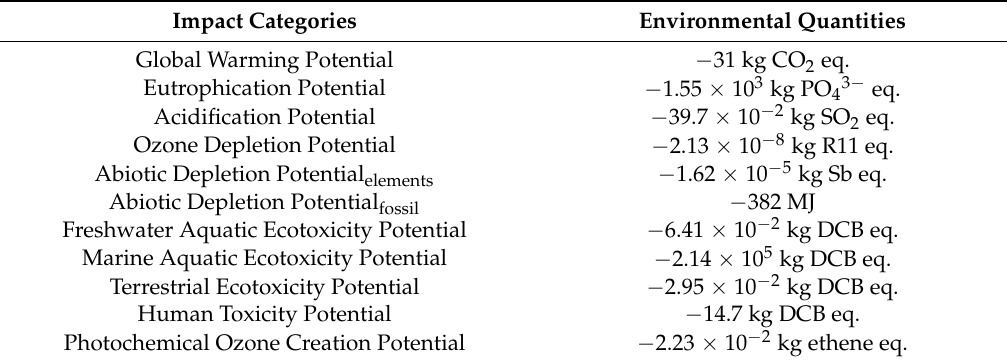
Table 3. Environmental results for the impact categories assessed during municipal solid waste (MSW) two-stage plasma